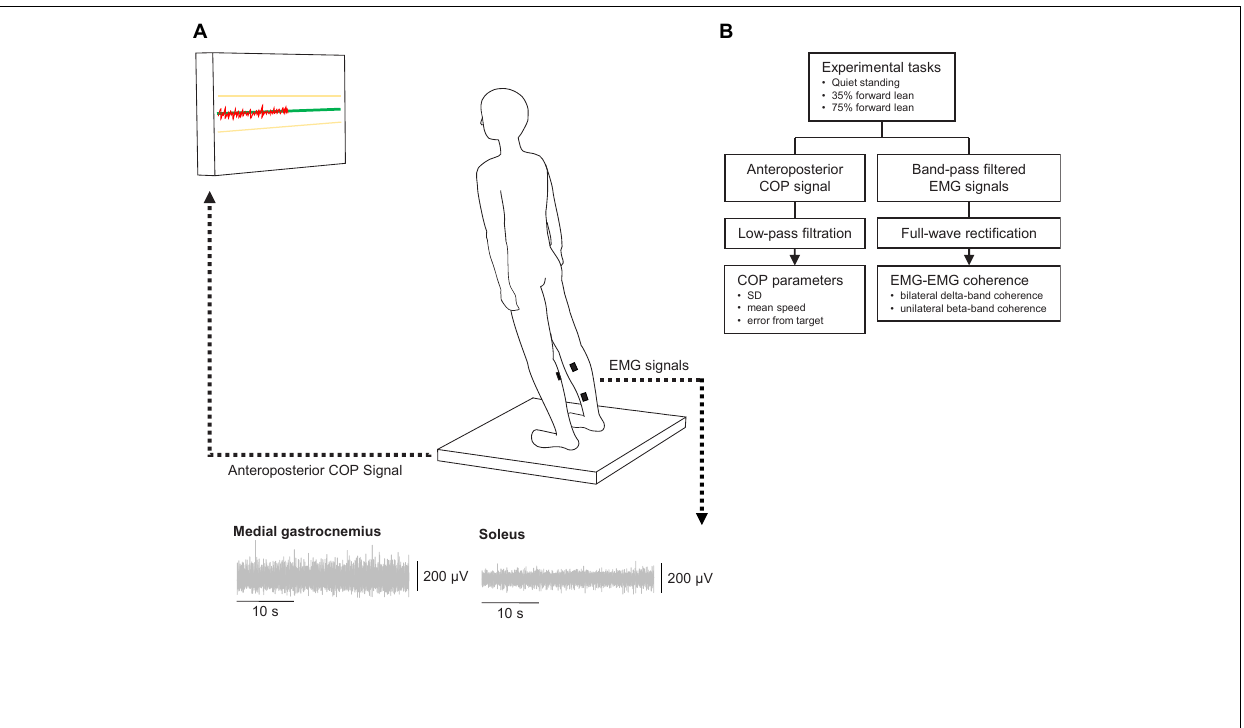
FIGURE 1 | Illustration of the experimental setup (A) and flow chart of the experiment (B) . In forward lean tasks the subject stood on a force plate and was instructed to lean the body forward by dorsiflexing the ankle joint and keep the center of pressure (COP: red line) on the target line (green line) as accurately and consistently as possible. We recorded electromyograms (EMGs) from the bilateral medial gastrocnemius and soleus muscles using wireless